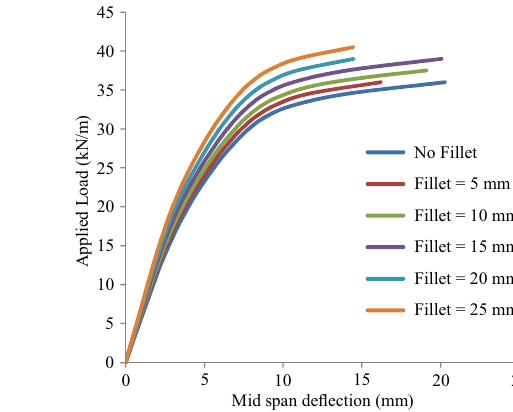
Fig. 11. Load vs mid span deflection for beam of different fillet Fig. 12. Load vs mid span deflection for beam of different fillet